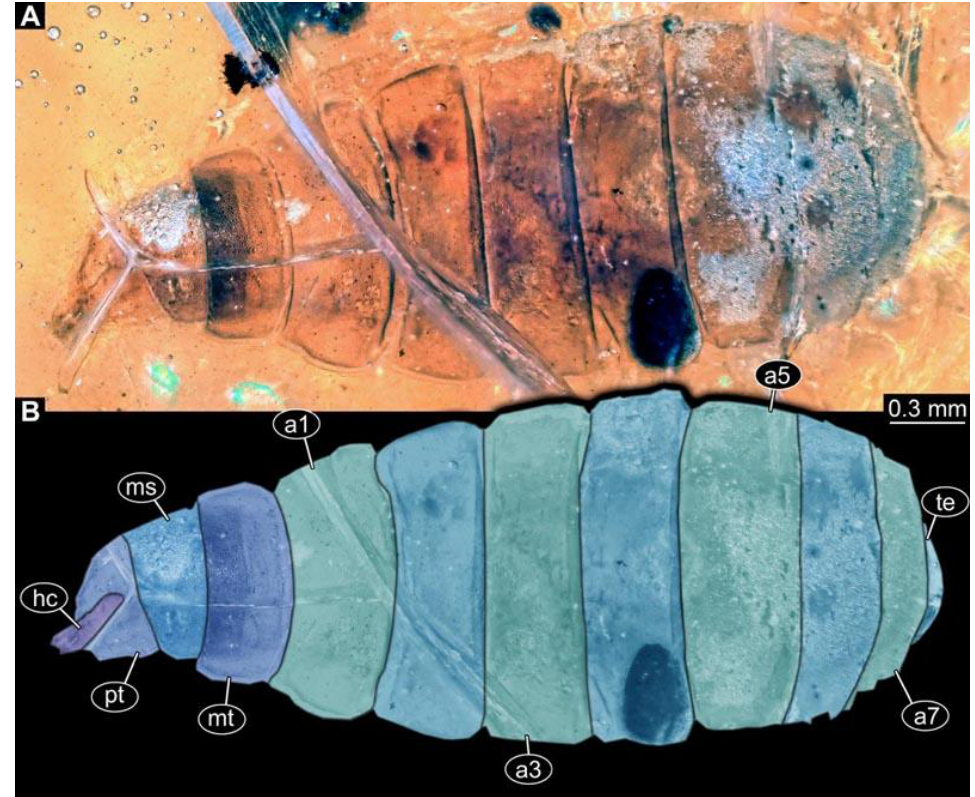
Figure 26. Fossil larva of morphotype 2 or 7, specimen PED 1262. ( A ). Dorsal view. ( B ). Colour- marked. Abbreviations: a1 – a7 = abdomen units 1 – 7; hc = head capsule; ms = mesothorax; mt = metathorax; pt = prothorax; te = trunk end.